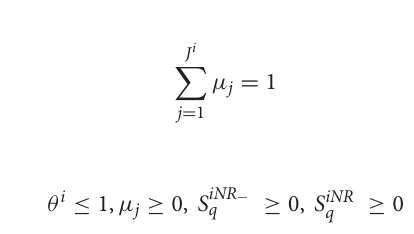
FIGURE 2 | The three regions of China divided in this